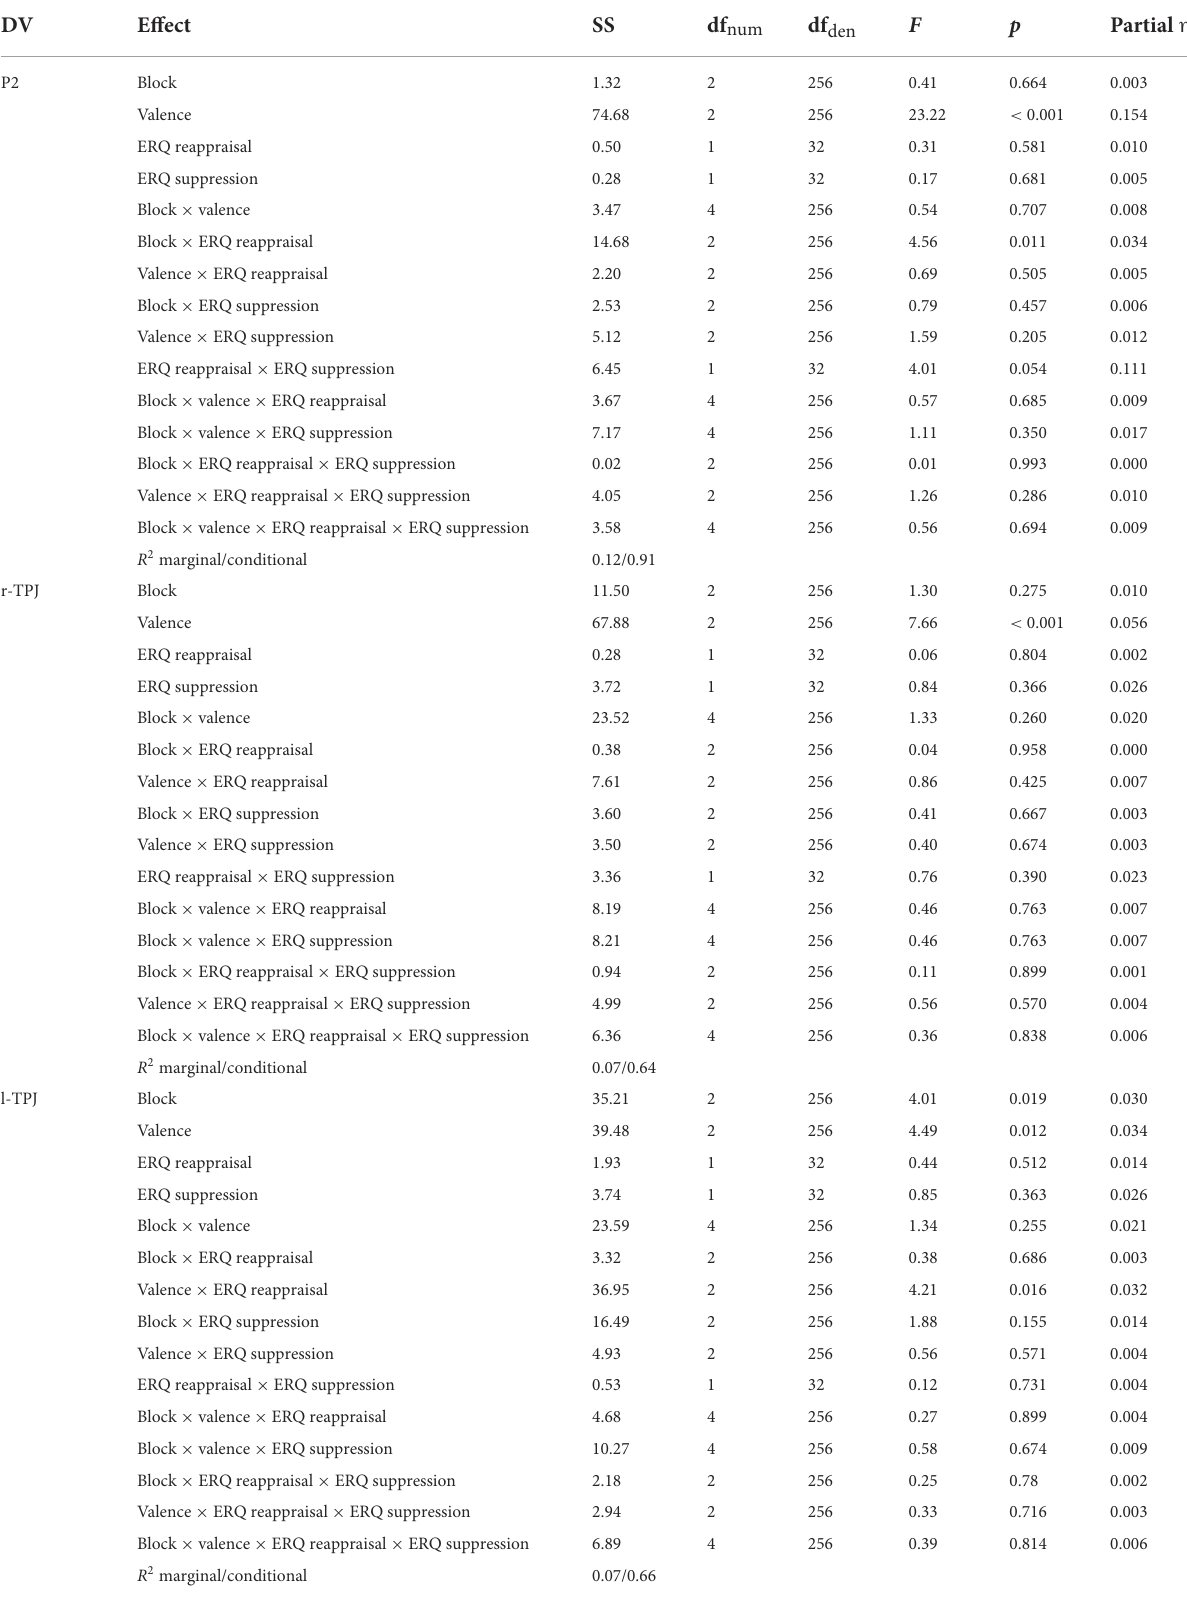
TABLE 3 ANOVA models in the prediction updating